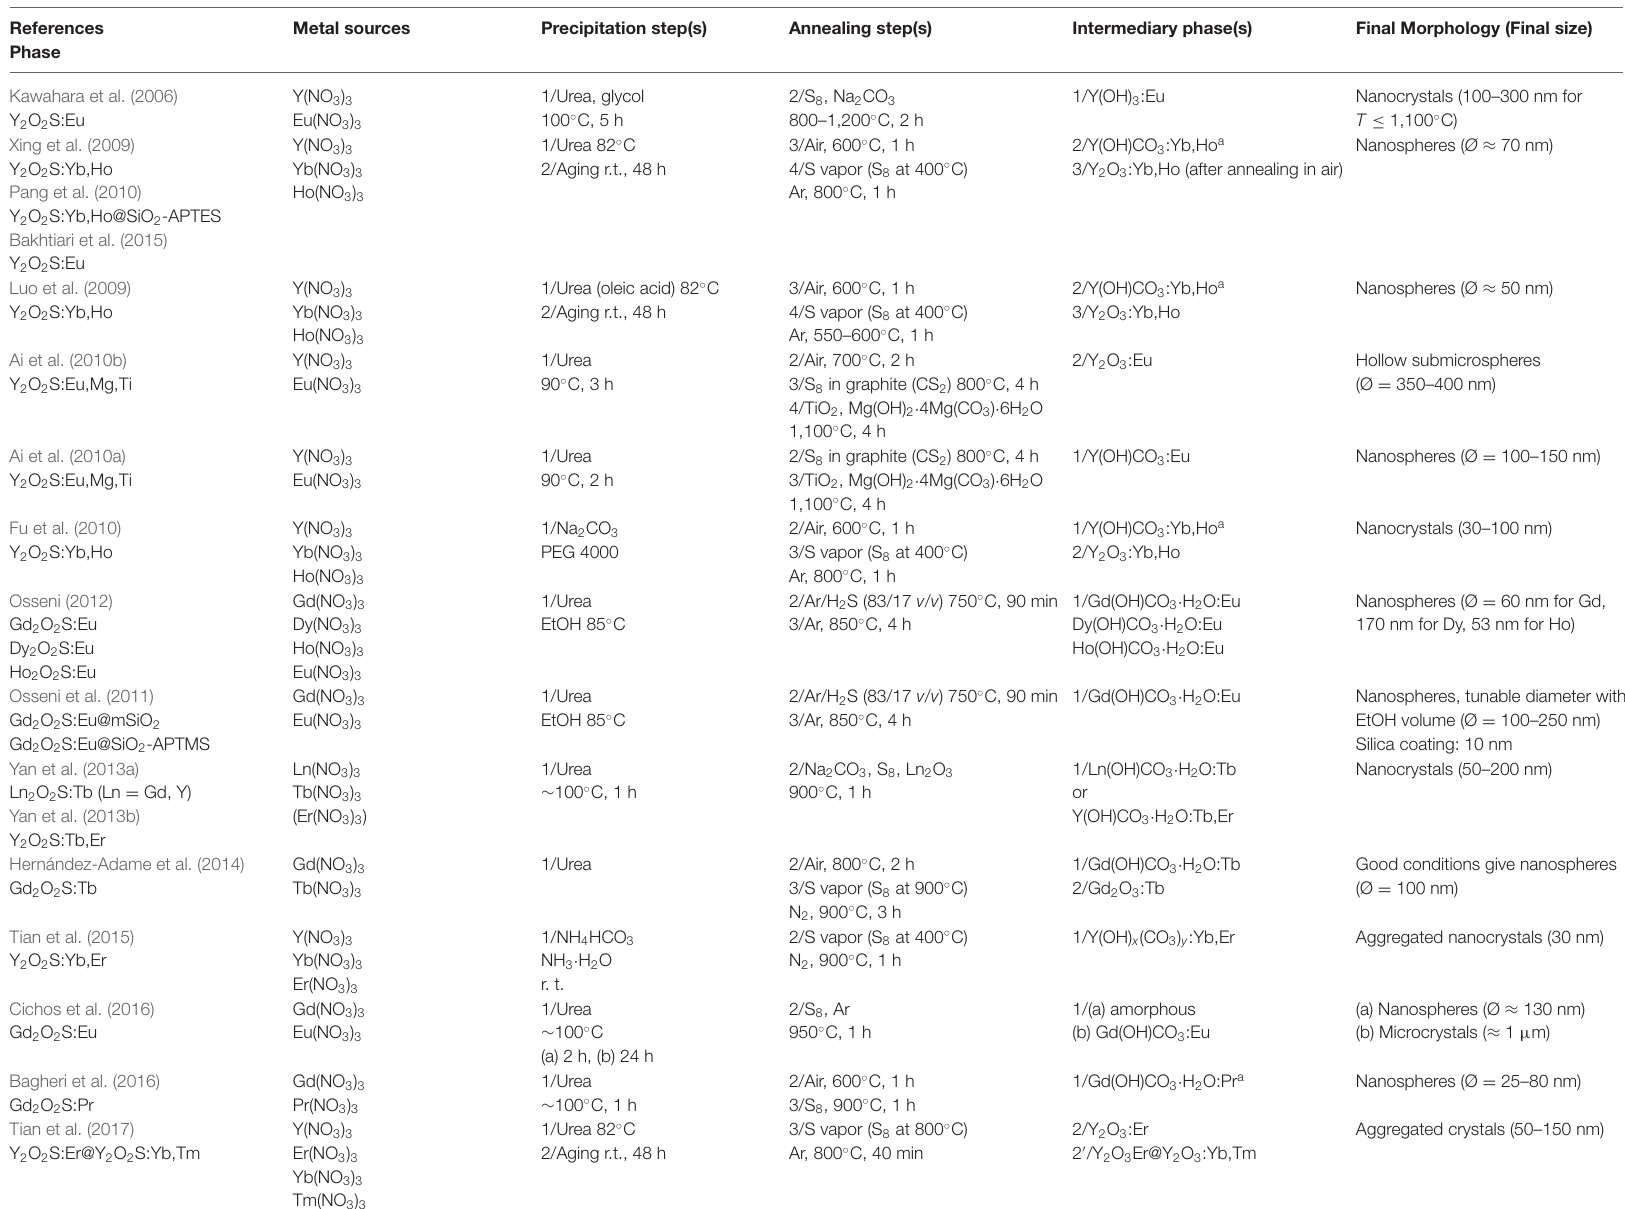
TABLE 3 | Precipitation from aqueous solutions at atmospheric